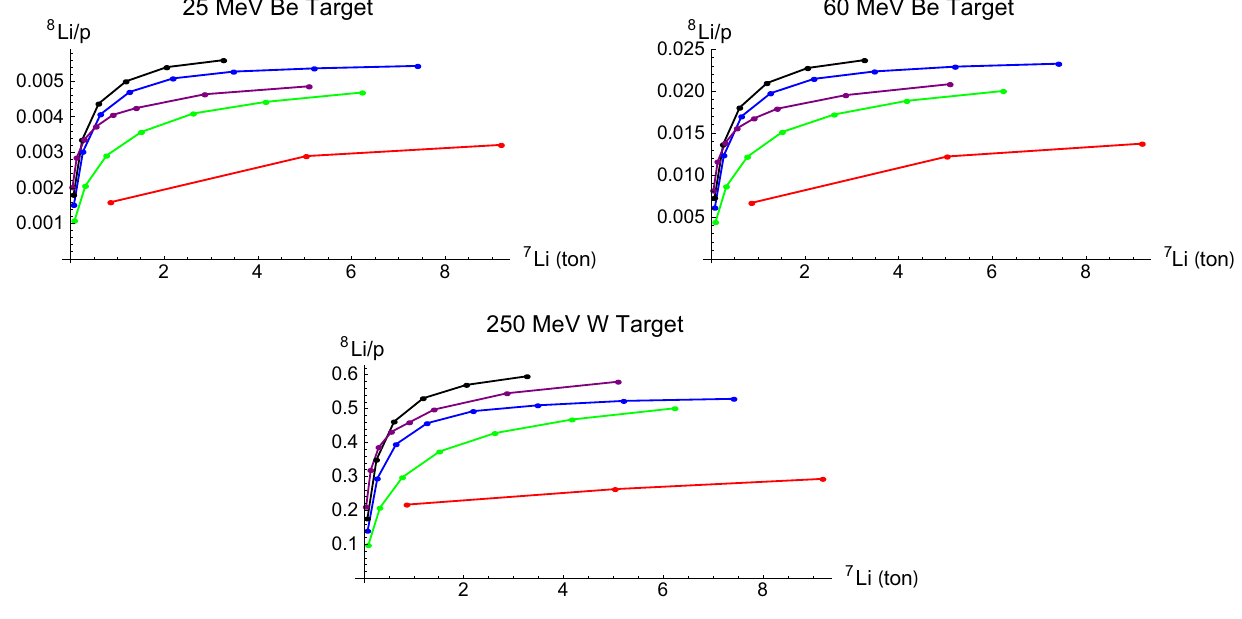
Fig. 7 As in Fig. 6 but the x -axis is the total converter mass instead of just the 7 Li